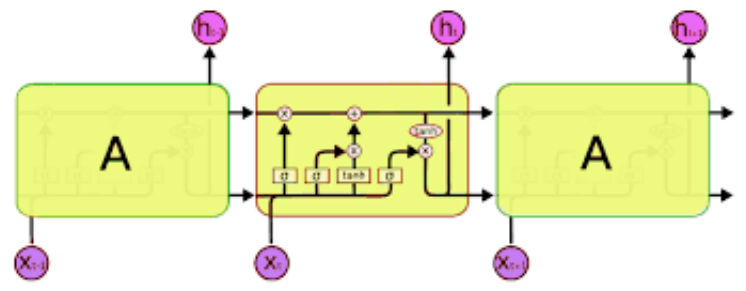
Figure 16. Long short-term memory